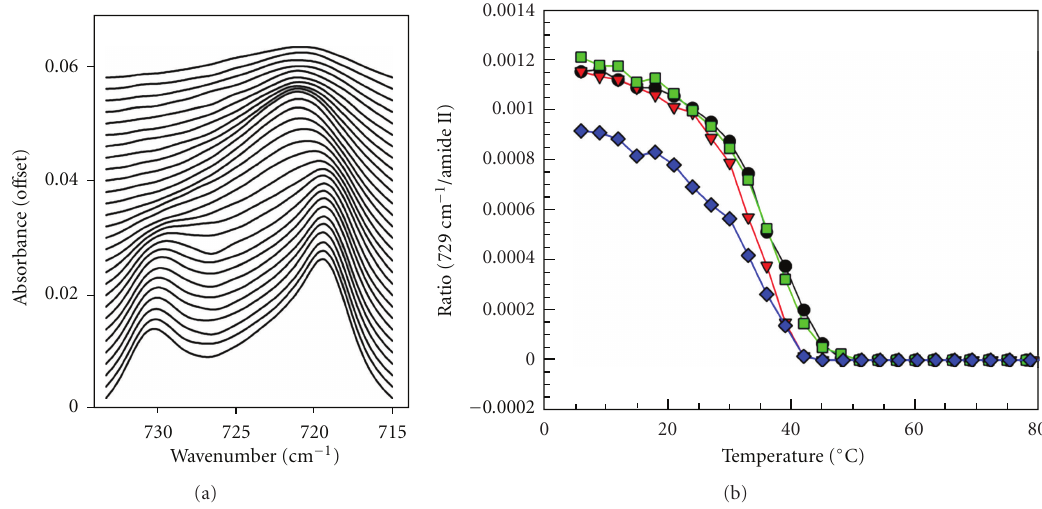
Figure 4: (a) CH 2 rocking band contour progression with temperature increase from 6 ◦ C (bottom) to 90 ◦ C (top) in 3 ◦ C increments a in an isolated human SC control sample; (b) integrated peak area of 729cm − 1 rocking band normalized by protein Amide II peak area as a function of temperature for 2h control (circles line), 2 h SDS-d 25 (down-pointing triangles line), 6 h control (square line), and 6h SDS-d 25 (rhombuses line) isolated human SC